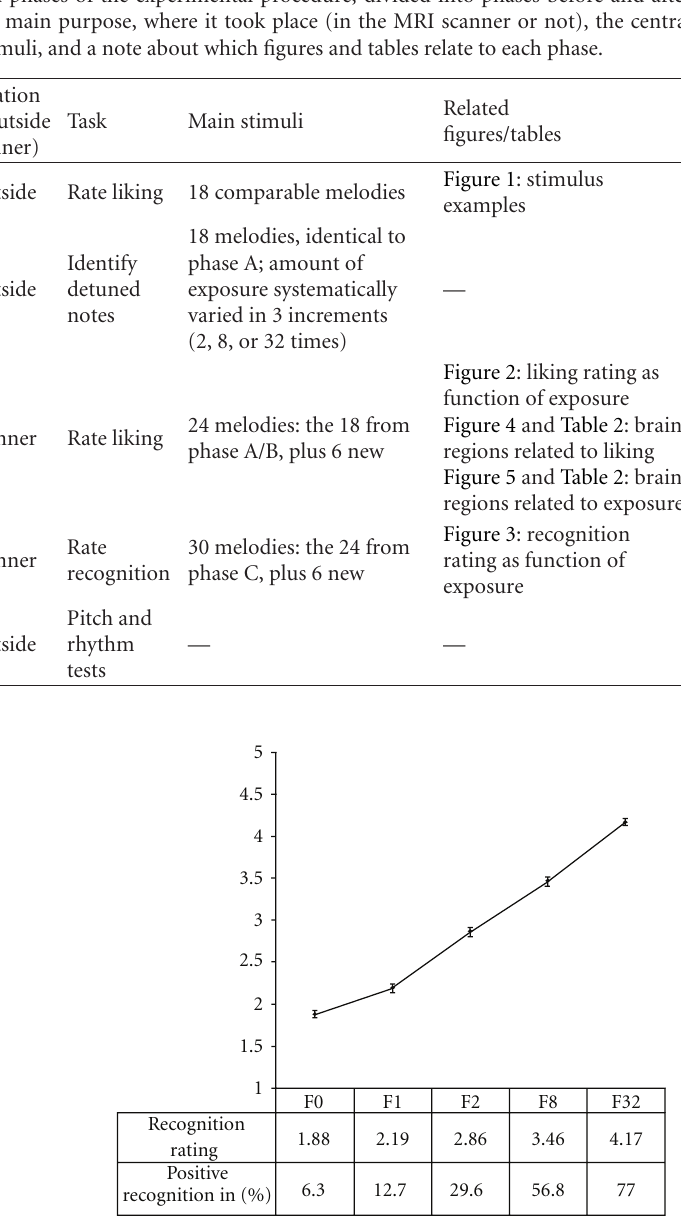
Figure 3: Recognition and previous exposure. Mean recognition ratings as a function of previous exposure (melodies heard 0, 1, 2, 8, or 32 times previously). Error bars represent standard error. The bottom line of the table shows the percentage of the total melodies in each exposure group that were rated as positively recognised, that is, given a rating of 4 or